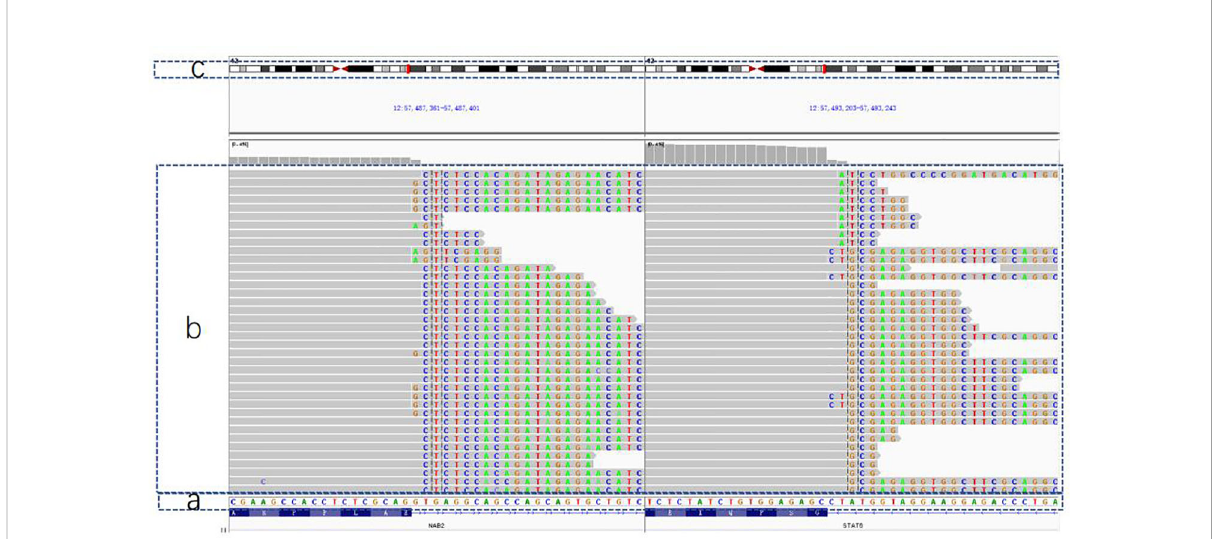
FIGURE 4 The outcome of genetic testing with GRCh37/hg19 genome for reference. (A) The normal gene sequence for contrast. (B) The patient's gene: gene orders in the gray part are in accordance with (A) sequence and faulty orders are highlighted in different colors (C) A simple diagram of chromosome No. 12, which was thought to be broken in two sites and fused together so that the NAB2-STAT6 mutation came into